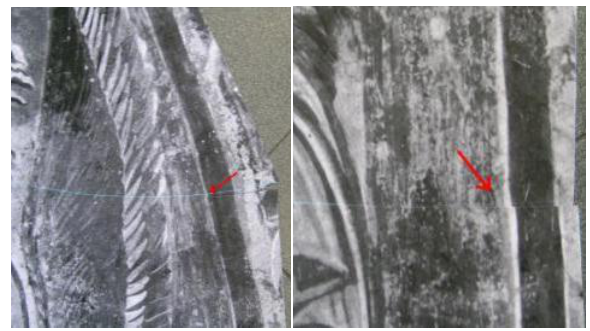
Figure 19. Mismatch during the first